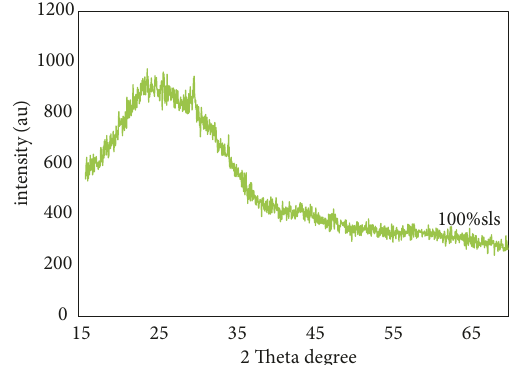
Figure 2: XRD spectrum of 100% SLS composites.